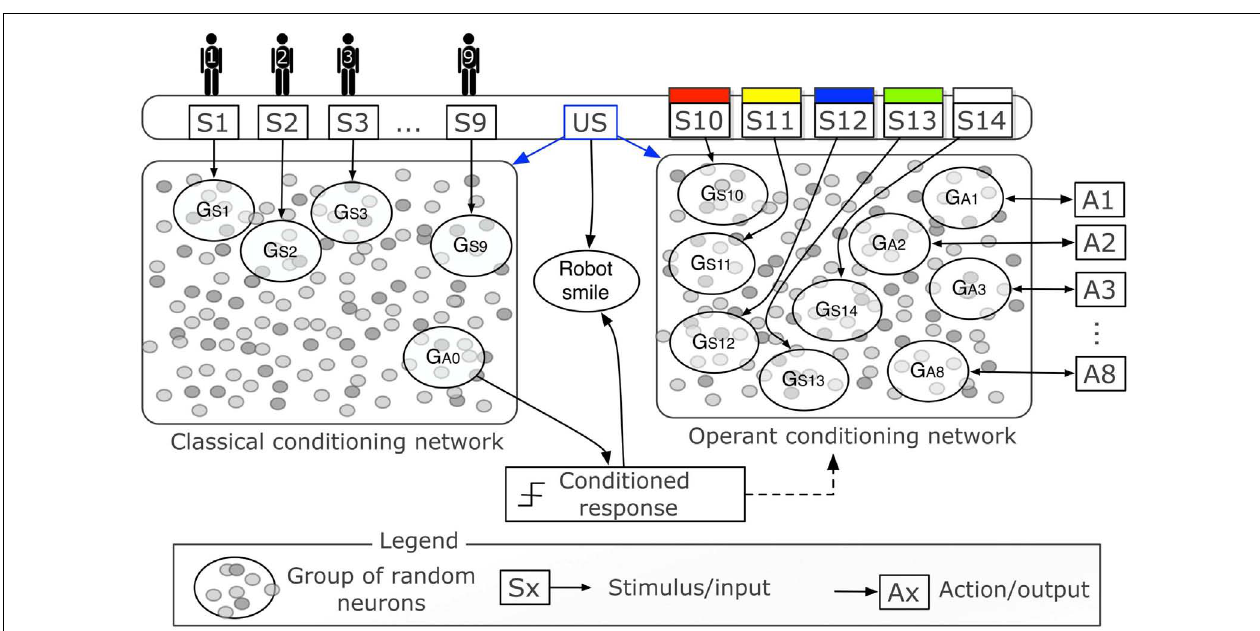
groups of random neurons G S 1 .. G S 9 .The binary stimuli S 10.. S 14 indicate the presence of objects of five different colors (all five colors were tested in simulation, only two, S10 and S11, with the real robot).The actions A 1.. A 8 correspond to the enunciation of one particular color.The haptic sensor delivers a reward that represents the unconditioned stimulus (US). Both the US and high activity of G A 0 cause the robot to